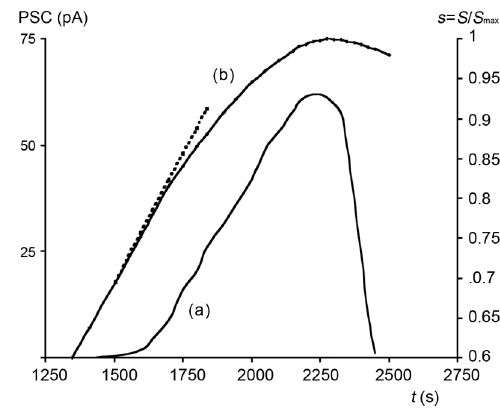
Fig. 3. Detailed representation of the temporal vari- ations of both PSC (curve a) and normalized stress applied on a marble sample (curve b) while the de- formation rate is kept